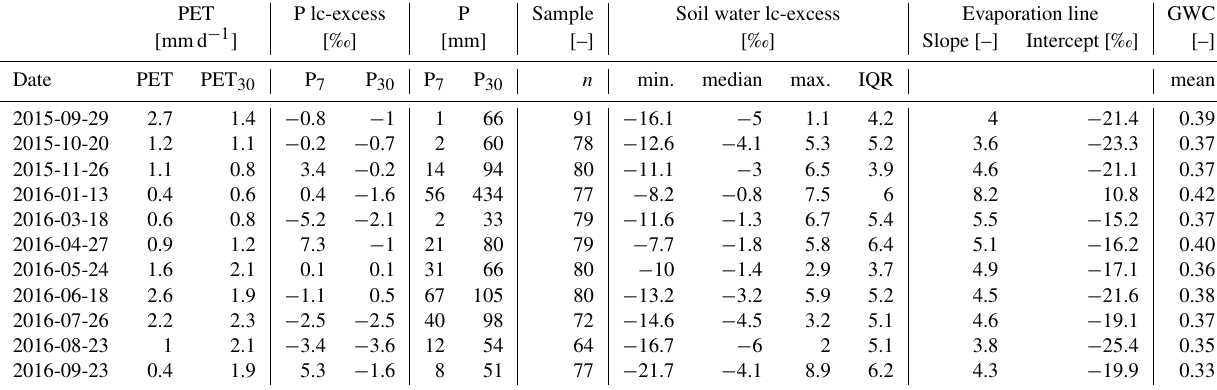
Table 2. For each soil sampling campaign: the PET on that sampling day; PET as average over the 30 days prior to the sampling day (PET 30 ) ; lc-excess of the precipitation input weighted averaged over 7 (P 7 ) and 30 (P 30 ) days, respectively; precipitation summed over 7 (P 7 ) and 30 (P 30 ) days prior to soil sampling; total soil sample number; minimum, median, maximum, and interquartile range (IQR) of the soil water lc-excess data; slope and intercept of the evaporation line (note that regression is significant at the 99% confidence interval); and mean gravimetric water content